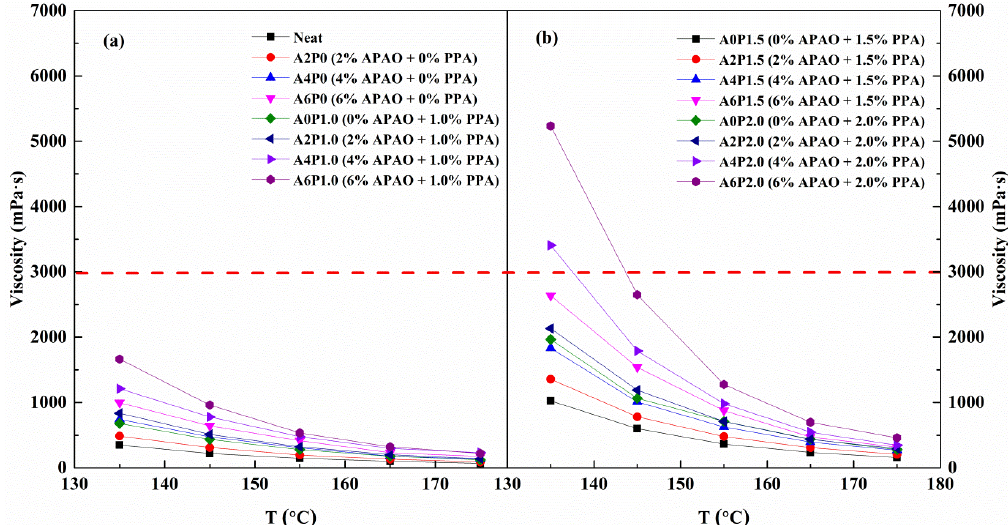
Figure 3. Variations in viscosity with temperature for all specimens: ( a ) composite modified binders with 0 wt.% and 1.0 wt.% PPA combined with 0-6 wt.% APAO; ( b ) composite modified binders with 1.5 wt.% and 2.0 wt.% PPA combined with 0-6 wt.% APAO.